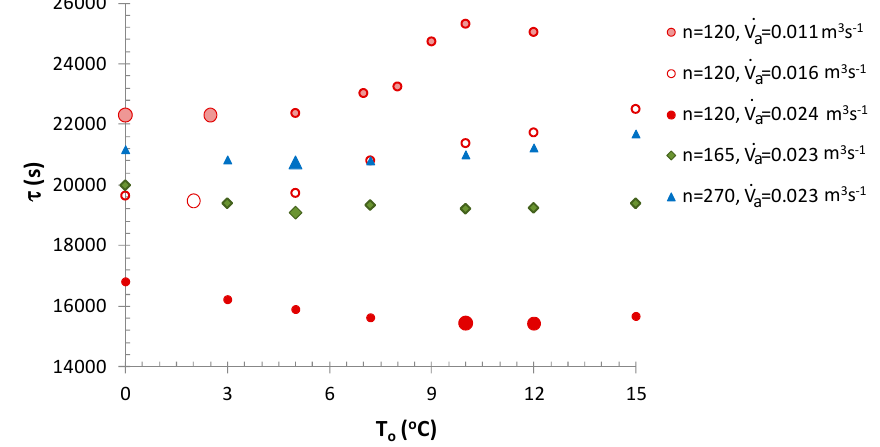
( T o ) and optimum evaporation temperature values T o-opt correspond- Figure 6. Drying time τ X (𝑇 ) and optimum evaporation temperature values T o-opt Figure 6. Drying time 𝜏 (cid:3025) (cid:3042) H < 20% (cid:3257) (cid:2996) (cid:2870)(cid:2868)% = τ ing to τ X = 𝜏 (cid:3040)(cid:3036)(cid:3041) . corresponding to 𝜏 (cid:3025) min H < 20% (cid:3257) (cid:2996)(cid:2870)(cid:2868)%